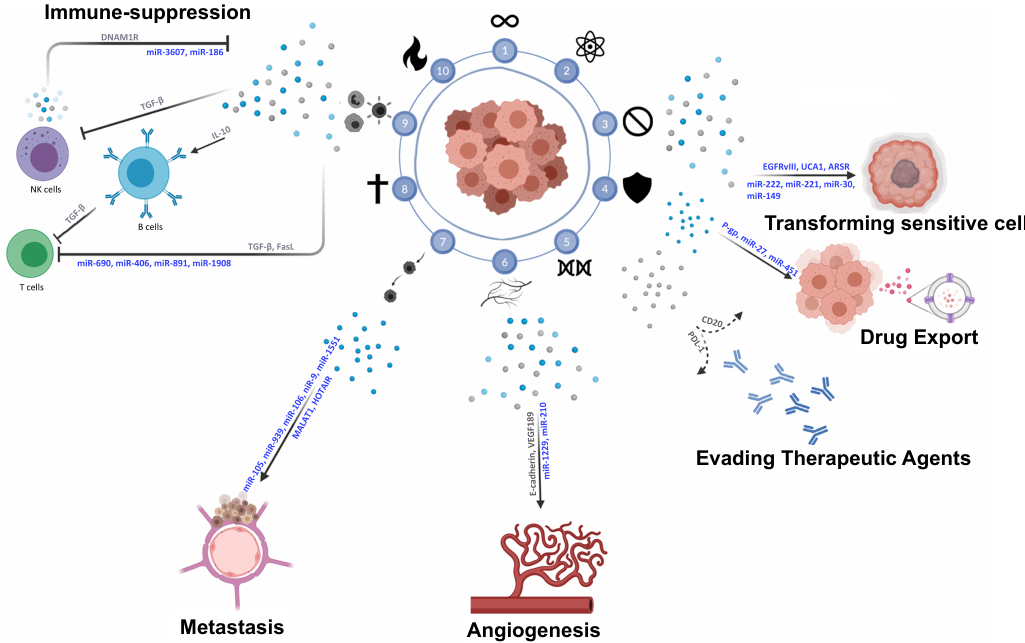
Figure 3. Extracellular vesicle-mediated tumor microenvironment (TME) communication. Schematic depiction of interactions in the TME between the tumor and surrounding cells promoting immune-suppression, angiogenesis, metastasis, and therapy-resistance. Factors and EVs in blue denote uptake-dependent processes; factors and EVs in grey denote uptake-independent